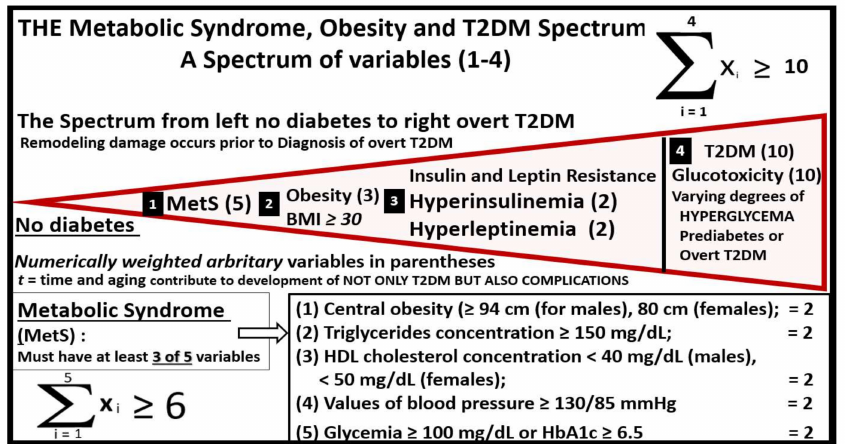
Figure 15. T2DM may be considered a spectrum disease. The development of overt or clinical